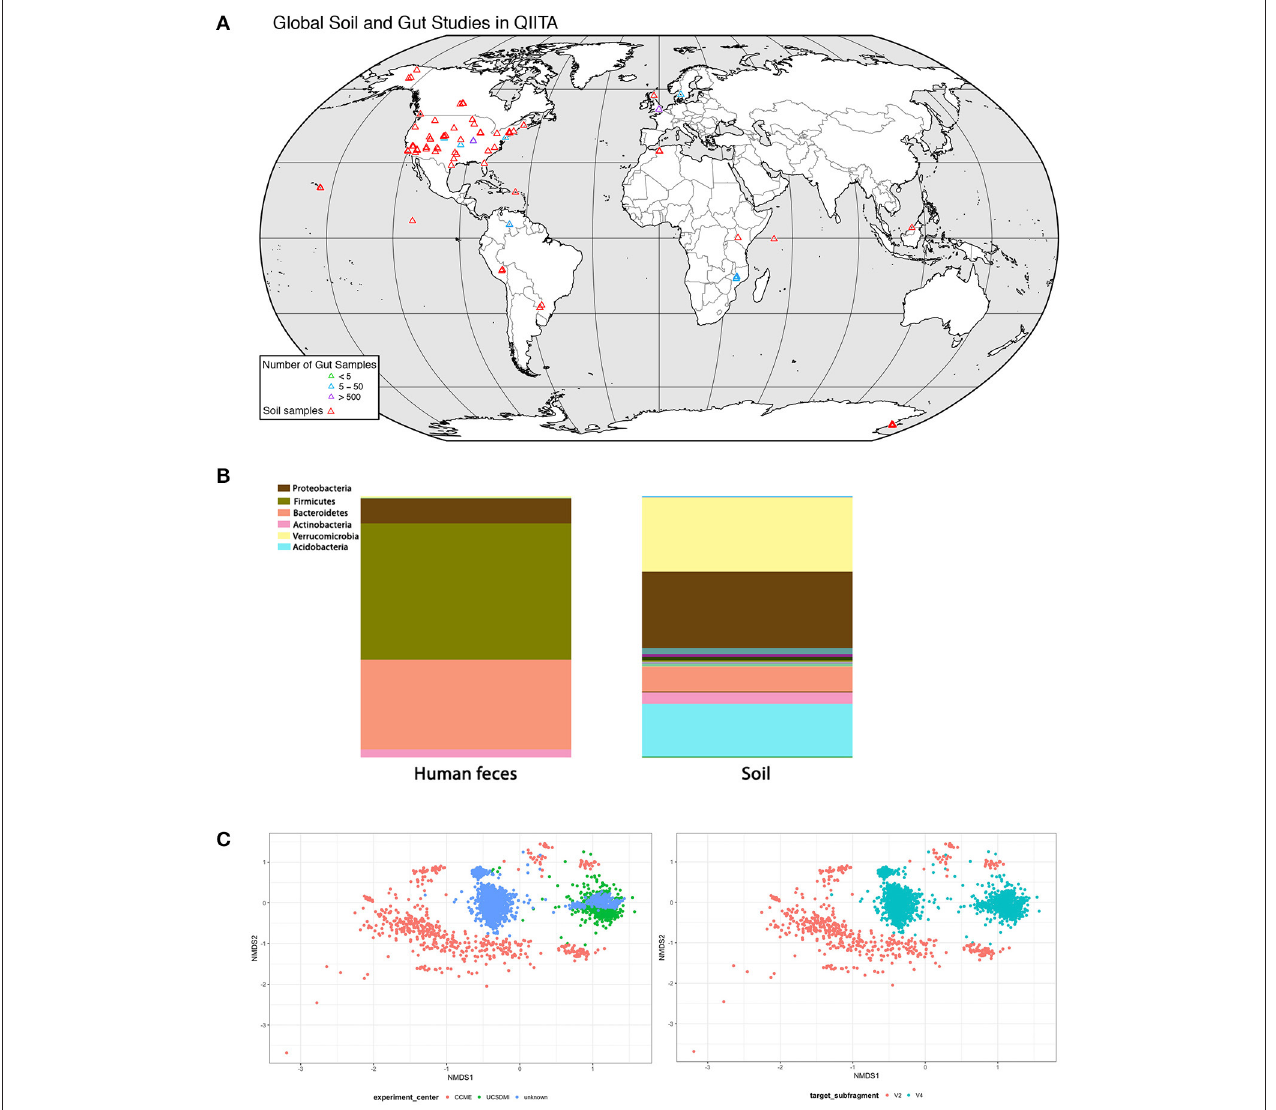
FIGURE 2 | Analysis of concurrence between gut and soil microbiome studies (data deposited in http://qiita.microbio.me) (A) Geographical range of soil (red symbols) and gut studies (green, blue, and purple symbols) available on QIITA. Studies are predominantly located in North America and Europe. Human fecal samples were collected from 14 countries, but the vast majority (66%) are from USA, Malawi, and Venezuela. Samples were collected from a range of ages (0–77 years). Soil samples were taken from a variety of habitats, including wetlands, garden soils, tundra, and tropical biomes. (B) Relative proportion of bacterial phyla in human feces ( n = 2,497) and soil ( n = 1,123) samples combined from seven gut and four soil studies in QIITA show little overlap of bacterial taxa. (C) Non-metric multidimensional scaling (NMDS) ordination plot of Bray-Curtis community dissimilarities on OTUs from 16s gene sequences from four US gut studies conducted by the same principal investigator (Rob Knight) (2D stress value = 0.16). Samples show clustering according to study center ( n = 935) (plot on left) as well as primer choice (plot on right) where V2 subfragment ( n = 35) or V4 subfragment ( n = 900) is targeted. Symbols represent individual fecal